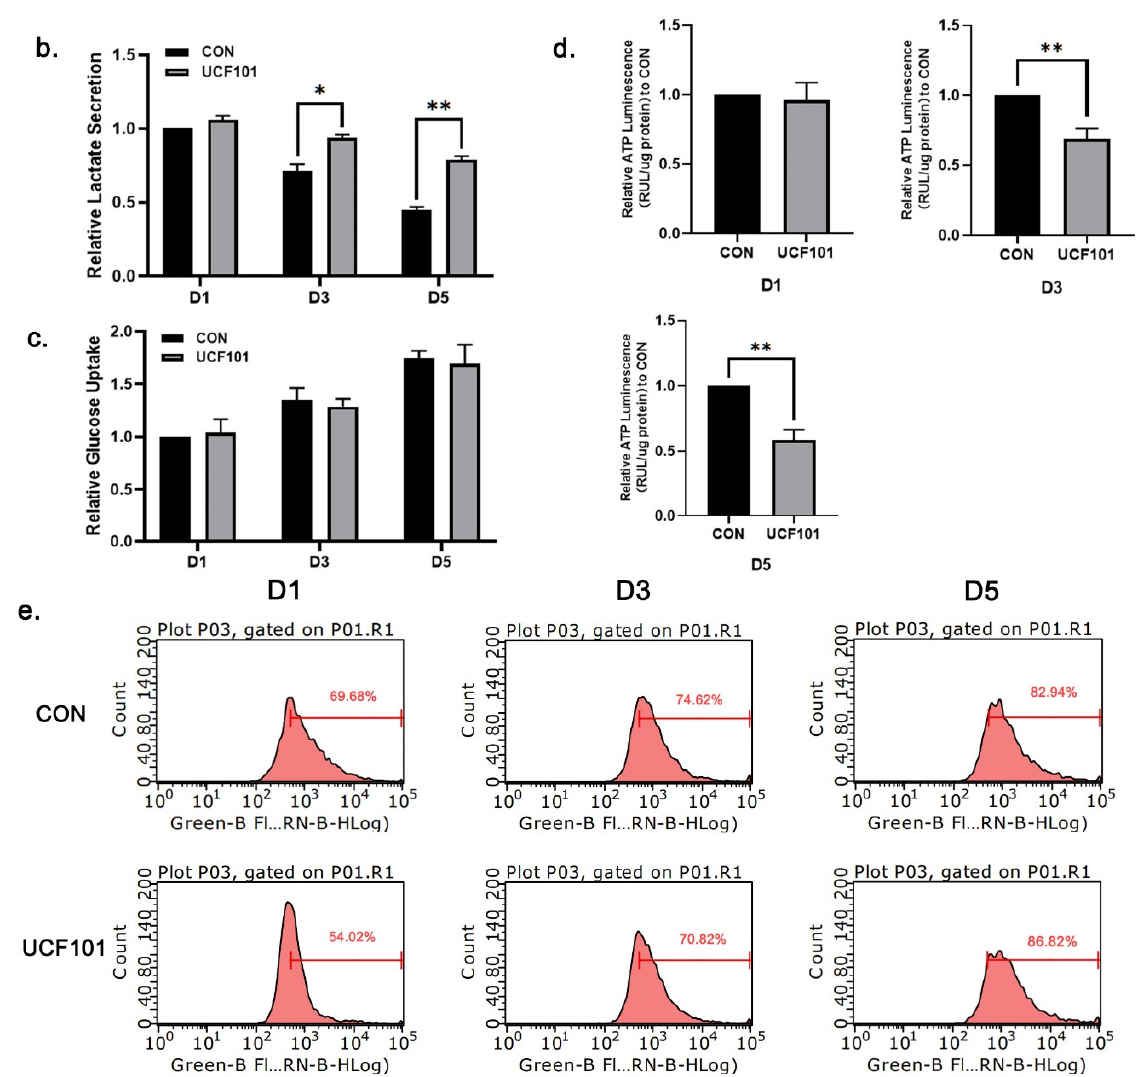
Figure 4. The levels of apoptosis, ROS, and energy metabolism markers during differentiation of C2C12 myoblasts. ( a ) Flow cytometric analysis of apoptotic rates of C2C12 myoblasts treated with UCF101 (20 µ M) or untreated following differentiation on D1, D3, and D5. ( b ) Accumulation of lactate in C2C12 myoblasts treated with UCF101 (20 µ M) or untreated since differentiation on D1, D3, and D5 within 24 h. Data were normalized to protein abundance. ( c ) Consumption of glucose of C2C12 myoblasts within 24 h. Data were normalized to protein abundance. ( d ) ATP content of C2C12 myoblasts determined using an ATP assay kit. RLU was normalized to protein abundance. ( e ) Flow cytometric analysis of ROS levels of C2C12 myoblasts treated with UCF101 (20 µ M) or untreated following differentiation on D1, D3, and D5. Two-tailed unpaired Student’s t -tests were used. Statistical significance: * p ≤ 0.05, ** p ≤ 0.01; RLU, relative luminescence unit; ROS, reactive oxygen